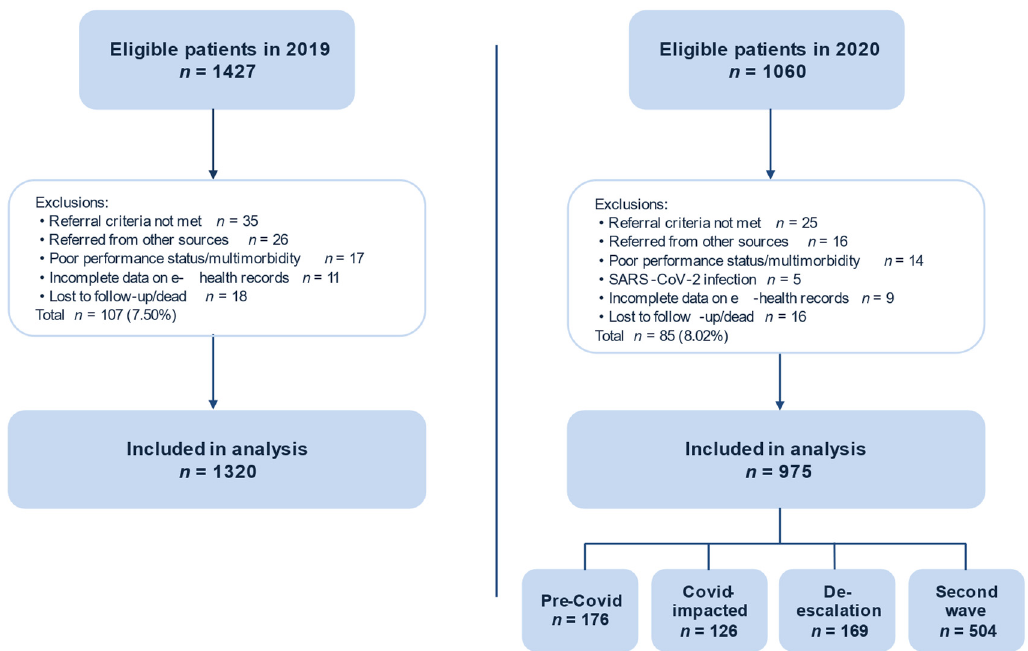
Figure 1. Study flow diagram. Inclusion and exclusion criteria are described in Methods. Abbreviations: SARS-CoV-2 = severe acute respiratory syndrome coronavirus 2.